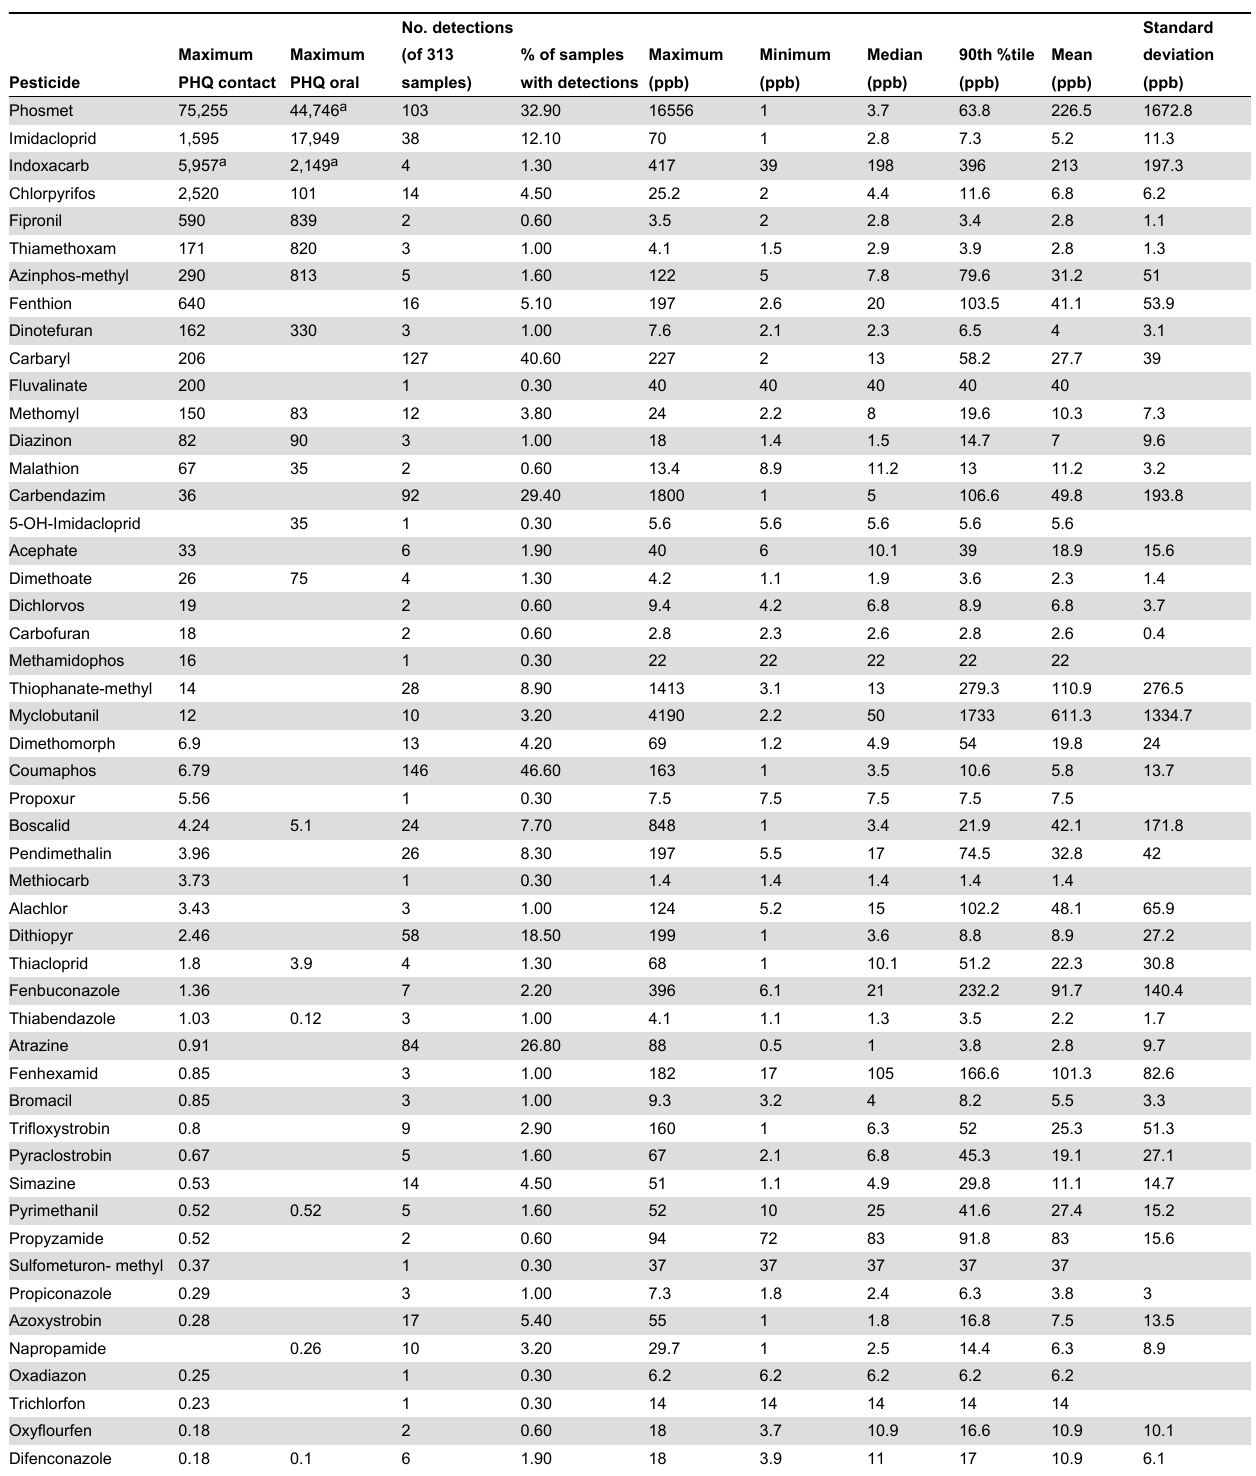
Table 2. Maximum pesticide residues found in trapped pollen presented as Pollen Hazard Quotients based on ratio of maximum residue (in ppb) ÷ LD (in ug/bee), and statistics on number of detections and range and variability of residue 50 concentrations in